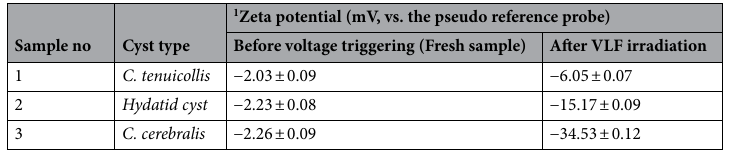
Table 5. Zeta potentials of different tested cysts before and after VLF irradiation. 1 Analyzed using the Zeta meter instrumentation system according to the recommended procedure under similar conditions. ± Relative standard deviation (n =